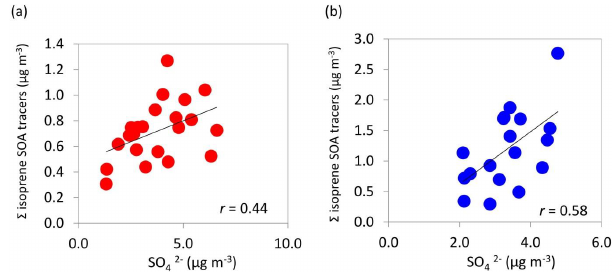
Fig. 14. Correlations between the sum of isoprene SOA tracers Figure 14. Correlations between the sum of isoprene SOA tracers (combining IEPOX- and 718 (combining IEPOX- and MAE-derived SOA) and the particle sul- MAE-derived SOA) and the particle sulfate loadings for all PM 2.5 samples collected in this study 719 fate loadings for all PM 2 . 5 samples collected in this study from from (a) June 25 to July 14, 2010 (SO 2 conditional sampling period) and (b) July 29, 2010 to 720 (a) 25 June to 14 July 2010 (SO 2 conditional sampling period) and (b) 29 July 2010 to 6 August 2010 (NH 3 conditional sampling pe- August 6, 2010 (NH 3 conditional sampling period). 721